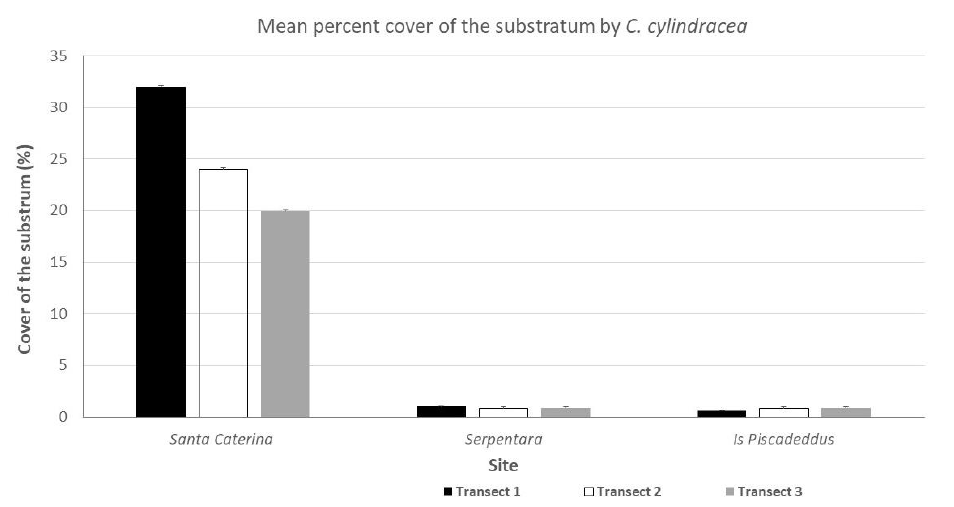
Figure 3. Mean ( ± SE) percent cover of the substratum by C. cylindracea in each of the three transects considered for the three sites.